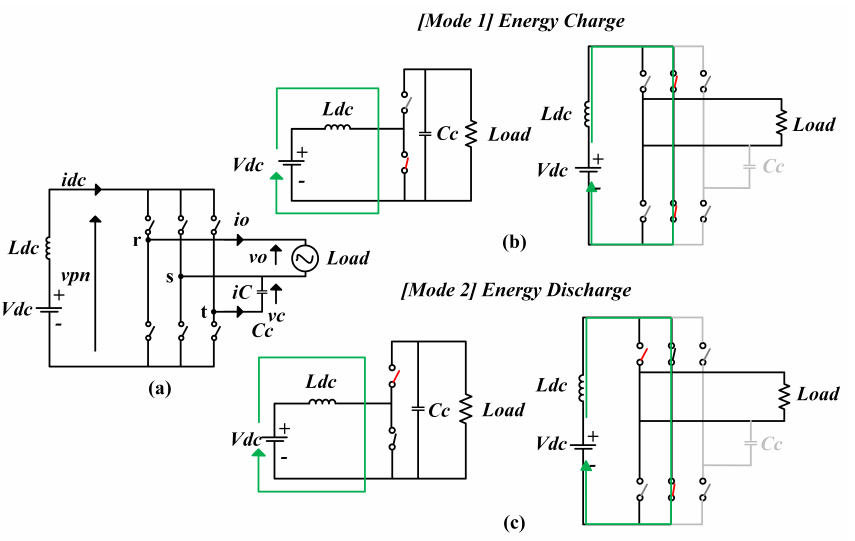
Figure 17. Topologies: ( a ) structure of the single-phase current source inverter with power decoupling function, ( b ) boost technique of conventional circuit, ( c ) boost technique of the presented